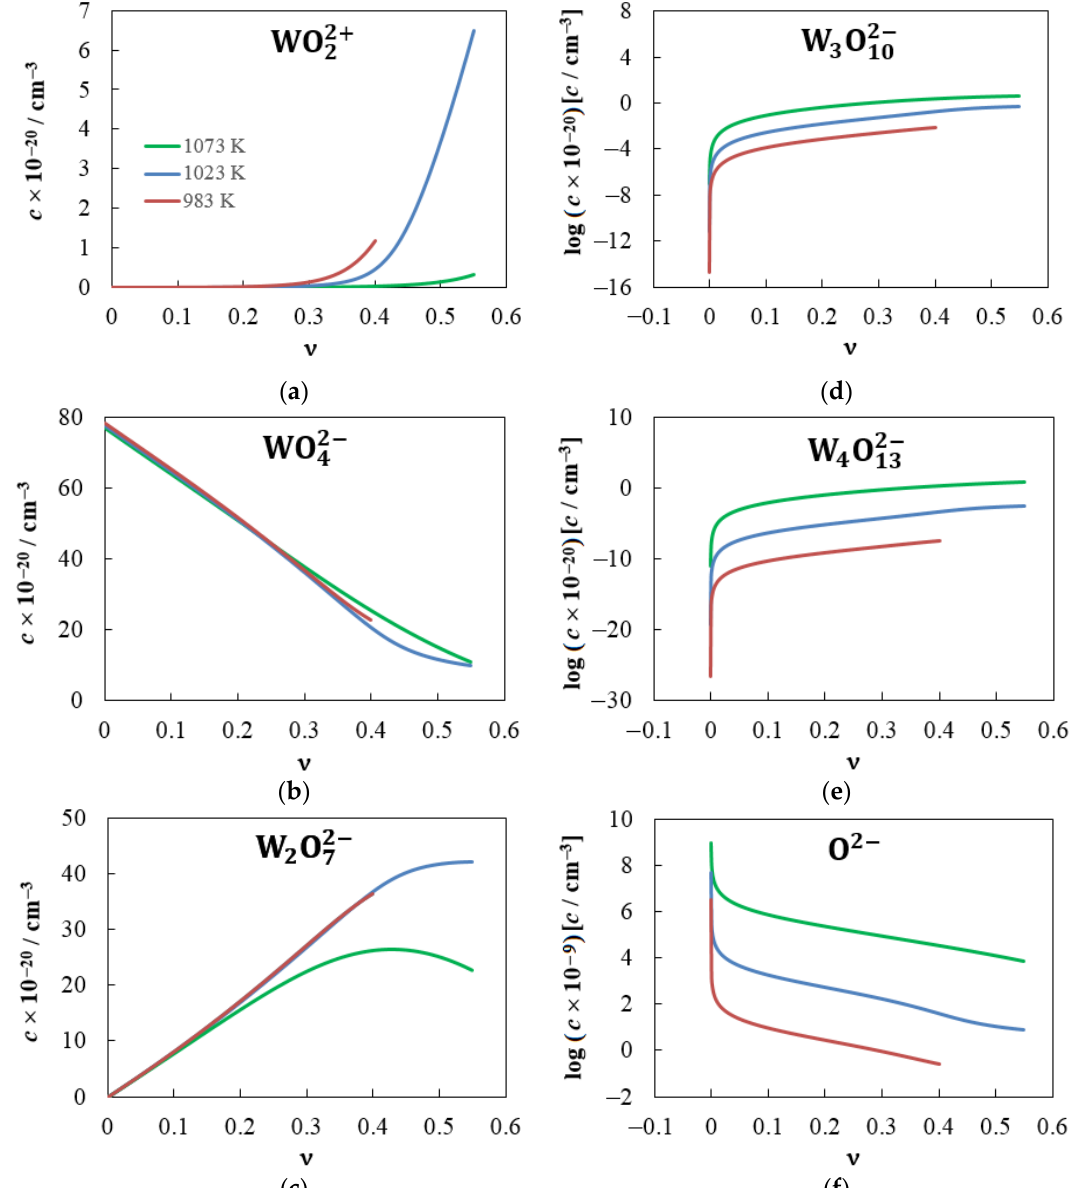
Figure 8. Dependences of the concentrations of tungsten-containing ions and O 2 − ions on the mole fraction of tungsten trioxide in Na 2 WO 4 –WO 3 melts at 983, 1023 and 1073 K.